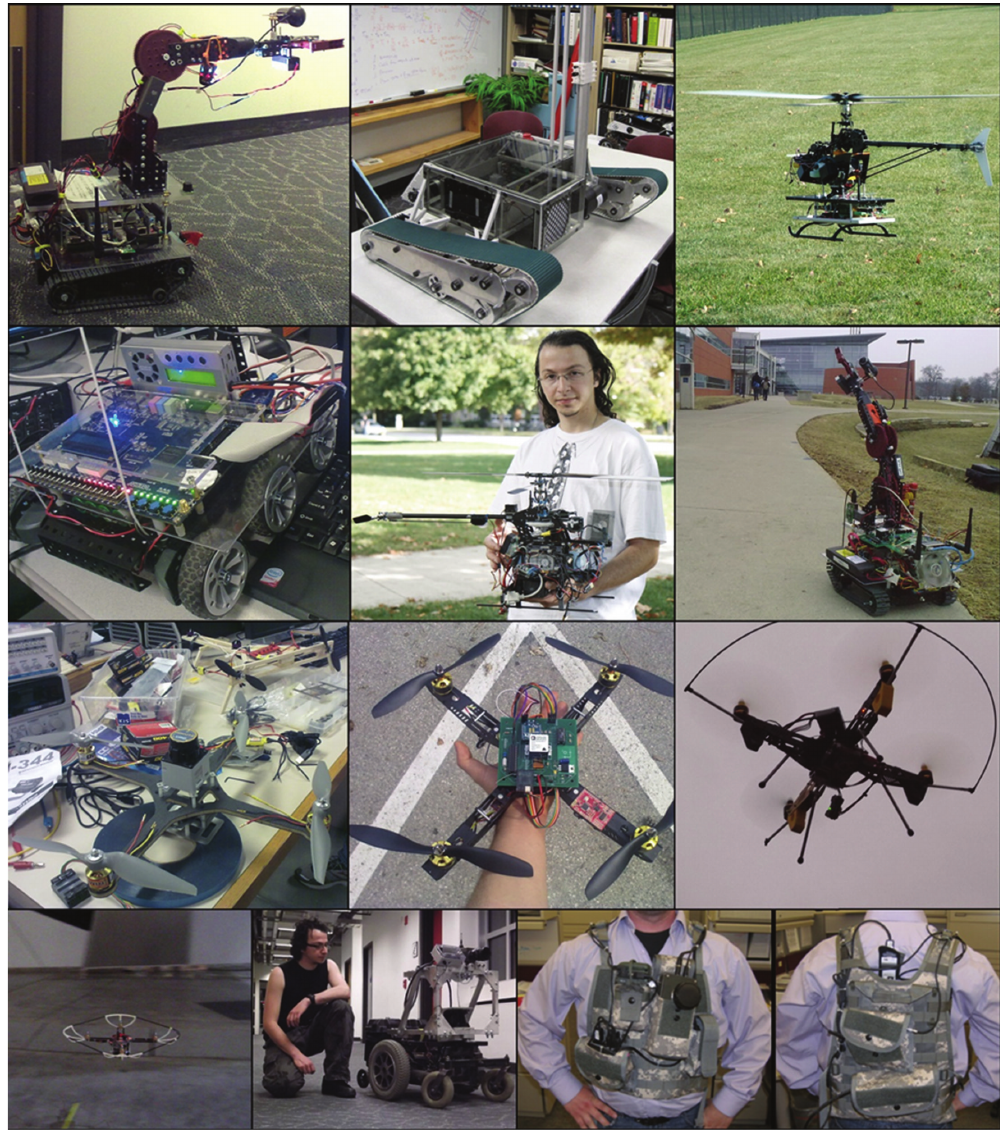
Figure 18: Our algorithms have been tested on a diverse set of mobile platforms shown here. Picture courtesy of Space Systems and Controls Lab, Aerospace Robotics Lab, Digitalsmithy Lab, and Rockwell Collins Advanced technology